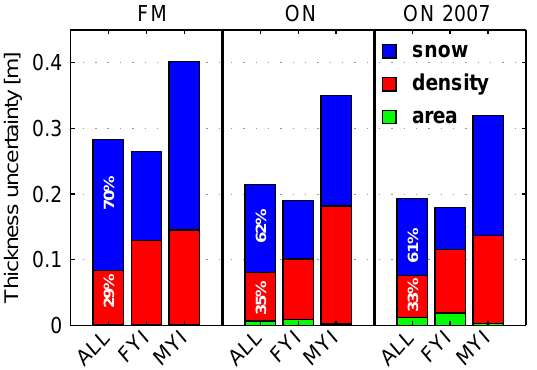
Fig. 6. Absolute uncertainties of the effective sea ice thickness. Contributions from uncertainties in sea ice density, snow depth, and sea ice area are included and given for the mean in Febru- ary/March (FM) and October/November (ON). Additionally, Octo- ber/November 2007 (ON07) is shown separately. Note that the dis- tributions of sea ice density and snow depth are non-Gaussian for the total sea ice (see PDFs in Fig. 2) and therefore the contributions from the three parameters over first-year ice (FYI) and multi-year ice (MYI) do not sum up for the total sea ice thickness